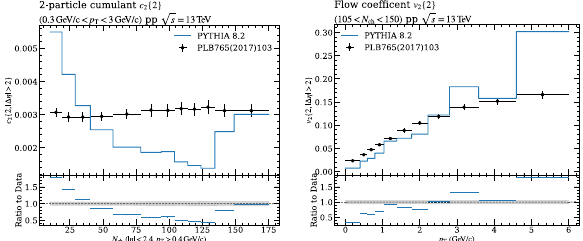
Fig. 12 Example flow observables from pp collisions [51], compared to simulation with Pythia 8.2. Analysis performed with the implemen- tation of the Generic Framework for flow measurements [32] presented in Sect.